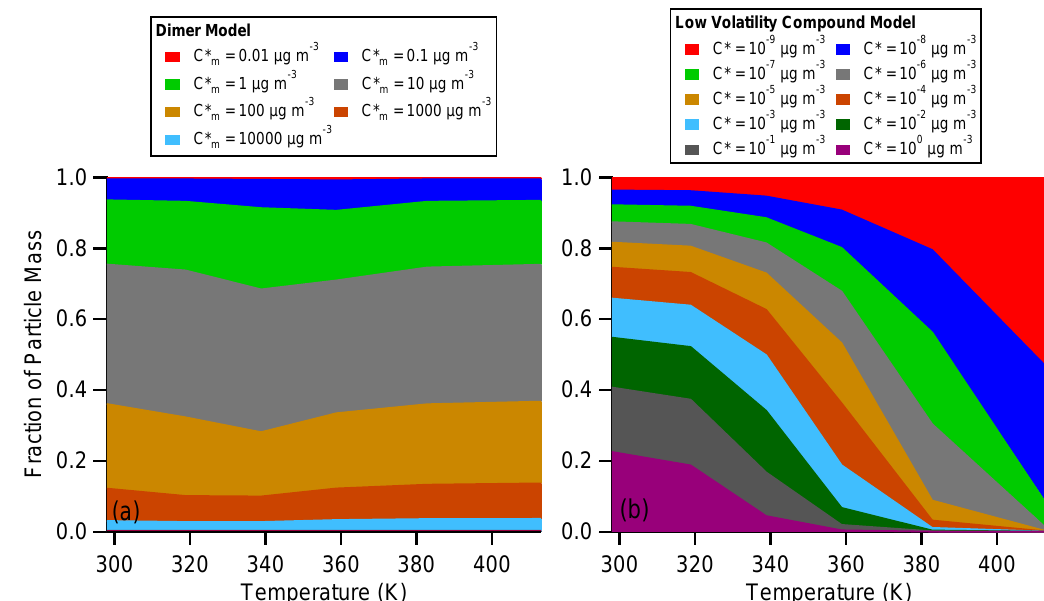
Figure 6. Variation in the relative particle composition with temperature from the (a) dimer-decomposition and (b) low-volatility monomer evaporation TD models. The colors correspond to the various dimer and monomer species, defined by the monomer C ∗ values. For the dimer- decomposition model the monomer fractional contributions are too small to be seen, and the reported C ∗ values in the legend correspond to the parent monomer values associated with each dimer. For the low-volatility monomer case, the C ∗ values correspond to the actual evaporating monomer values. The simulations were run for an initial C OA = 100µgm − 3 .